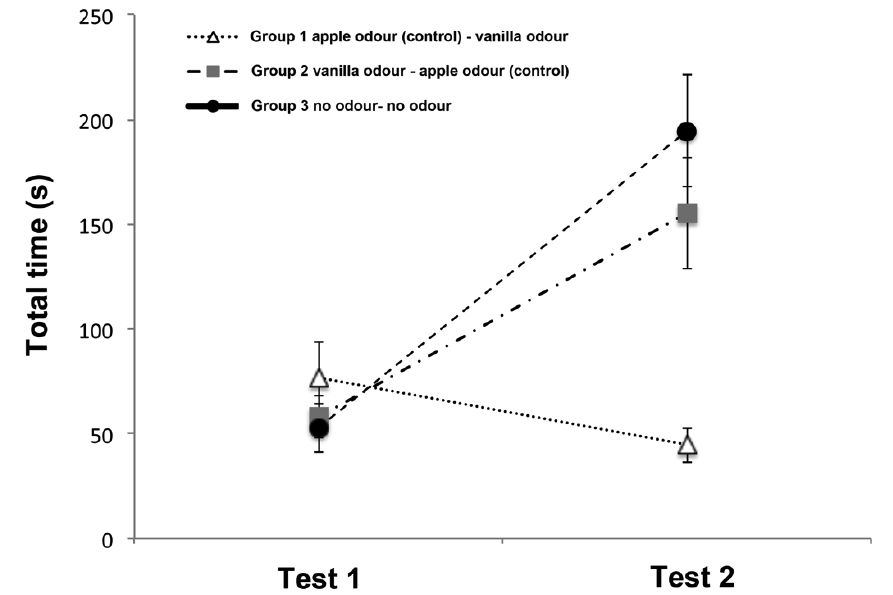
Figure 2. Graph showing the mean total time of the three groups spent exploring the correct 5 items on Test 1 and Test 2 in the Memory Retrieval Phase. The vertical lines show the standard error of each mean.